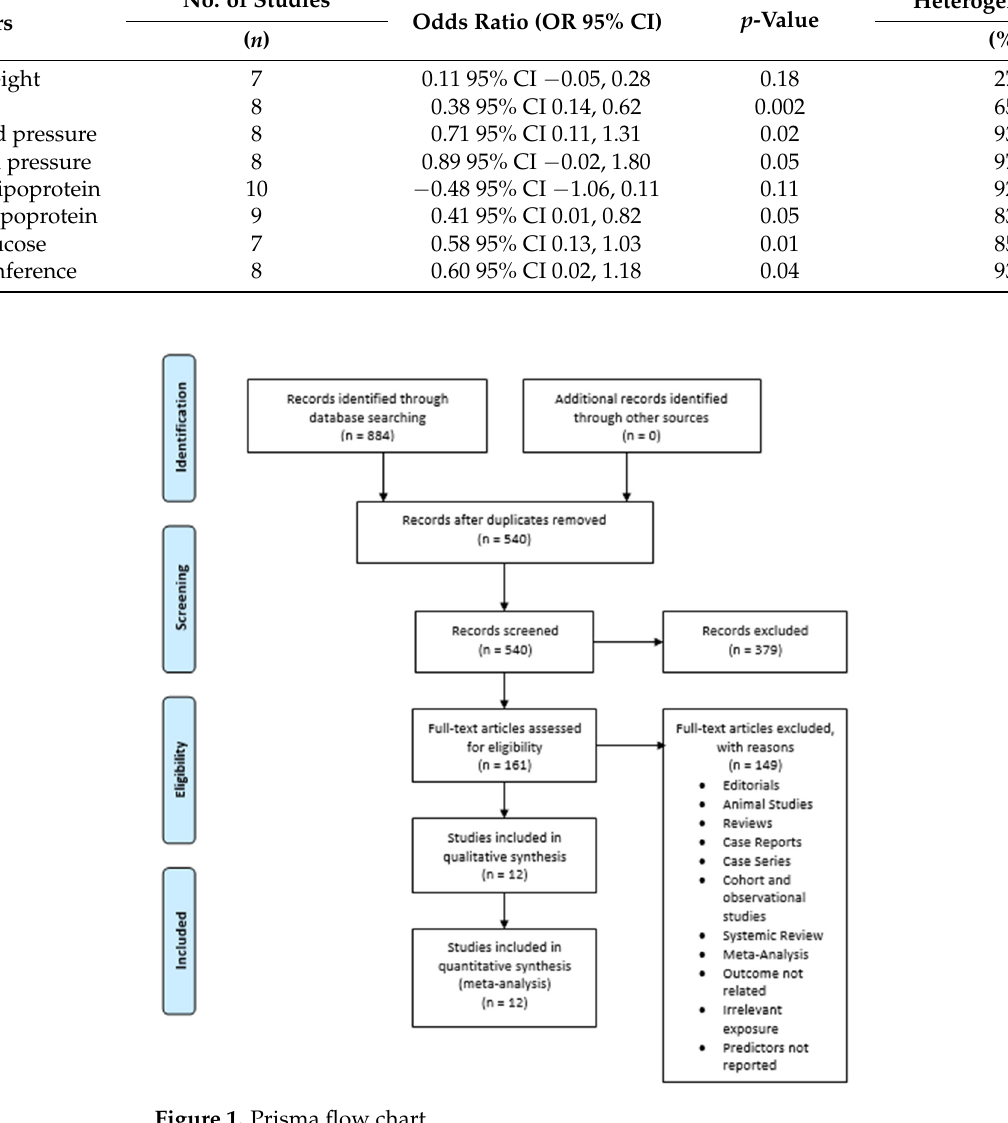
Figure 1. Prisma flow chart.